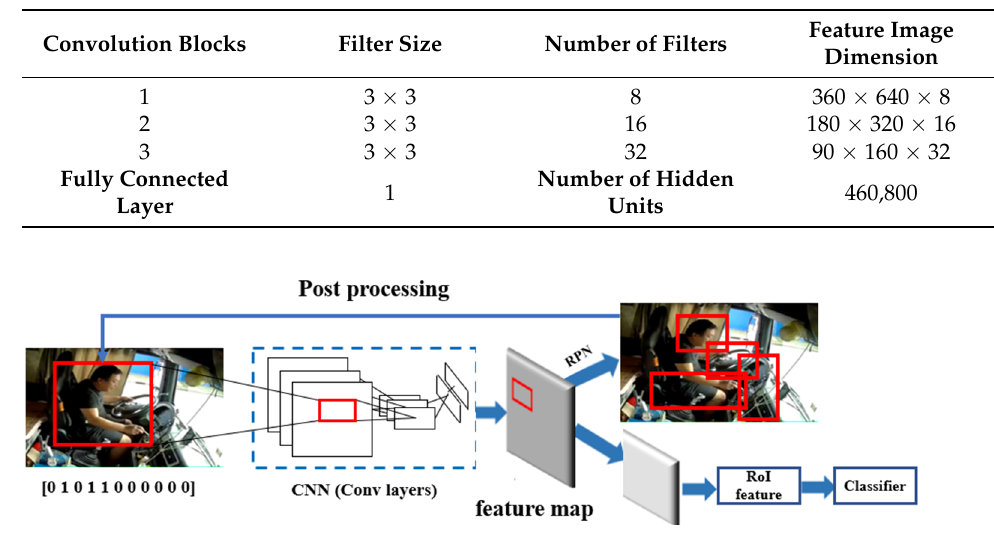
Table 3. Structure parameter table of CNN with an image resolution of 360 × 640.